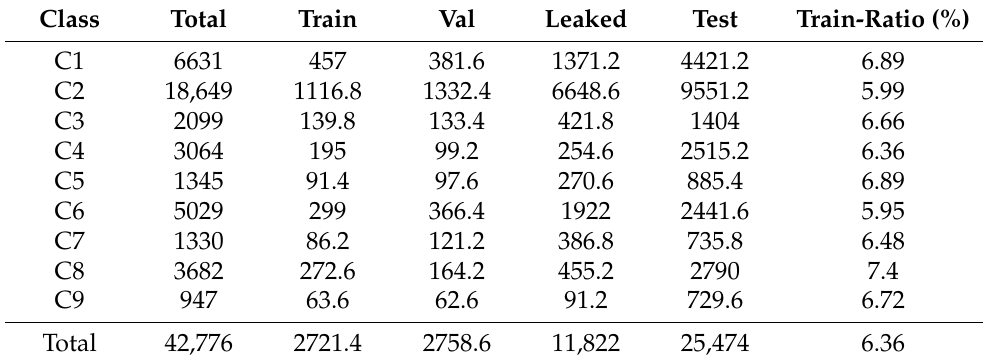
Table 2. Average number of training/validation/leaked/test pixels in Pavia University.